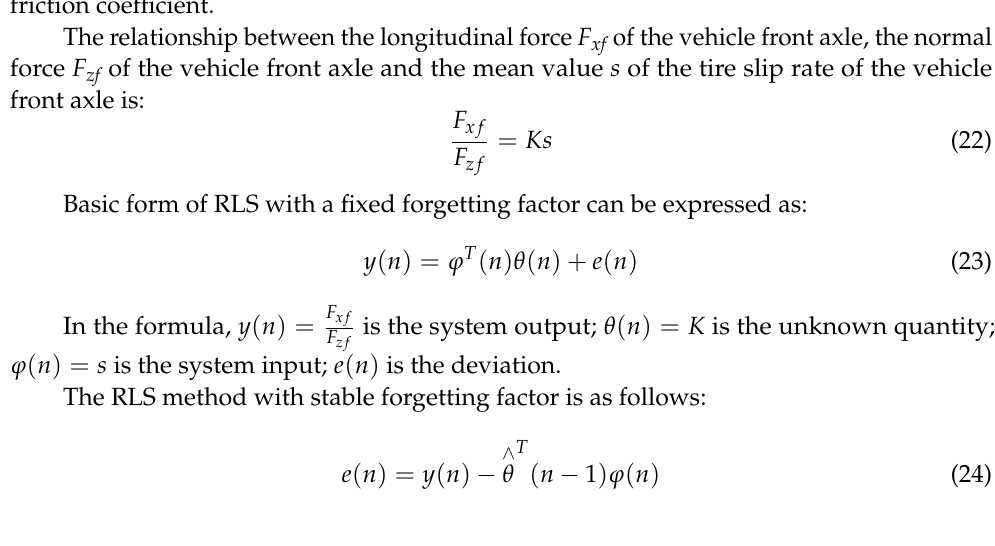
Figure 5. Static and dynamic wheel